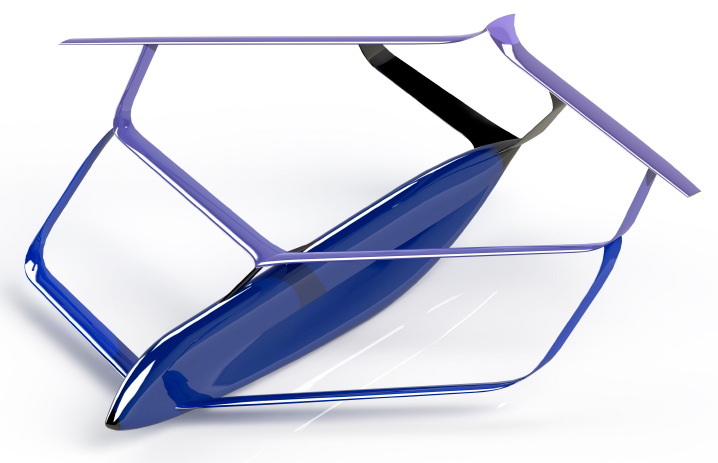
Figure 2. “SmartLiner” triplane Box-Wing Aircraft concept